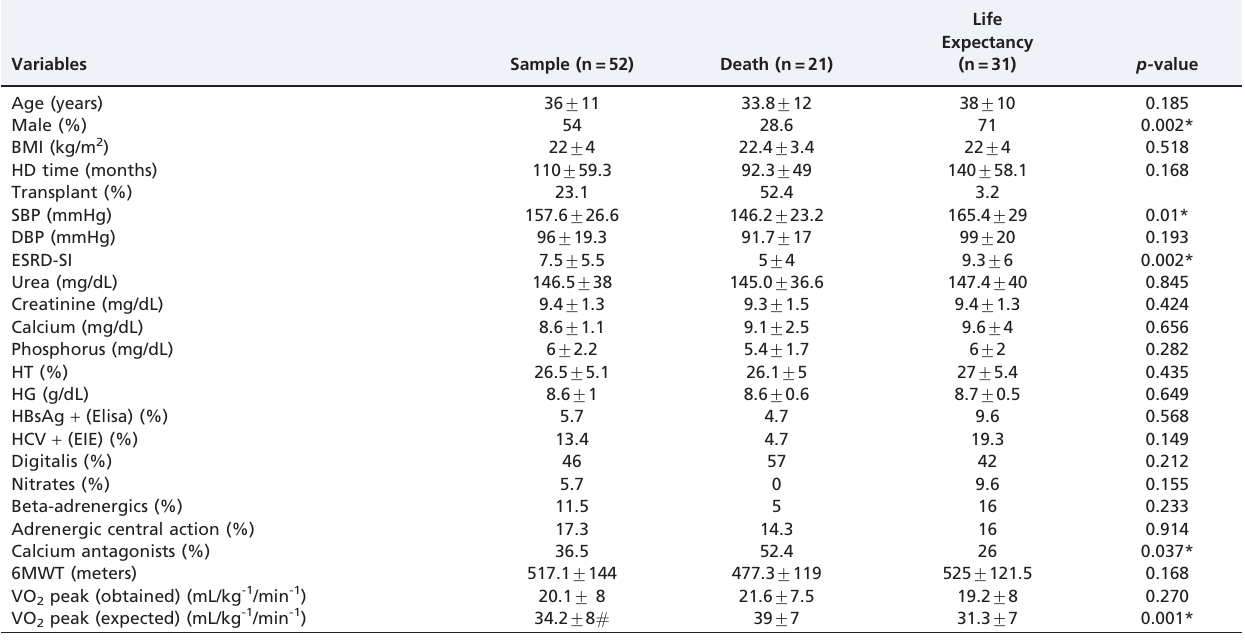
Table 1 - Clinic and biochemical characteristics of patients stratified by life expectancy and death.